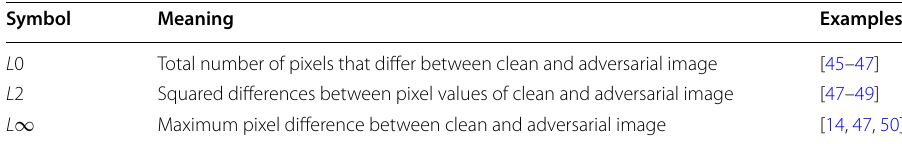
Table 2 Most popular distance norm used in adversarial images Symbol Meaning L 0 Total number of pixels that differ between clean and adversarial image L